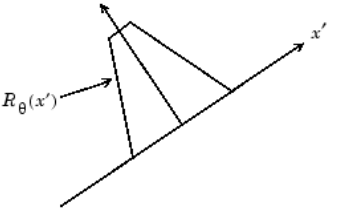
Figure 3. An arbitrary angle slice about a rectangle object